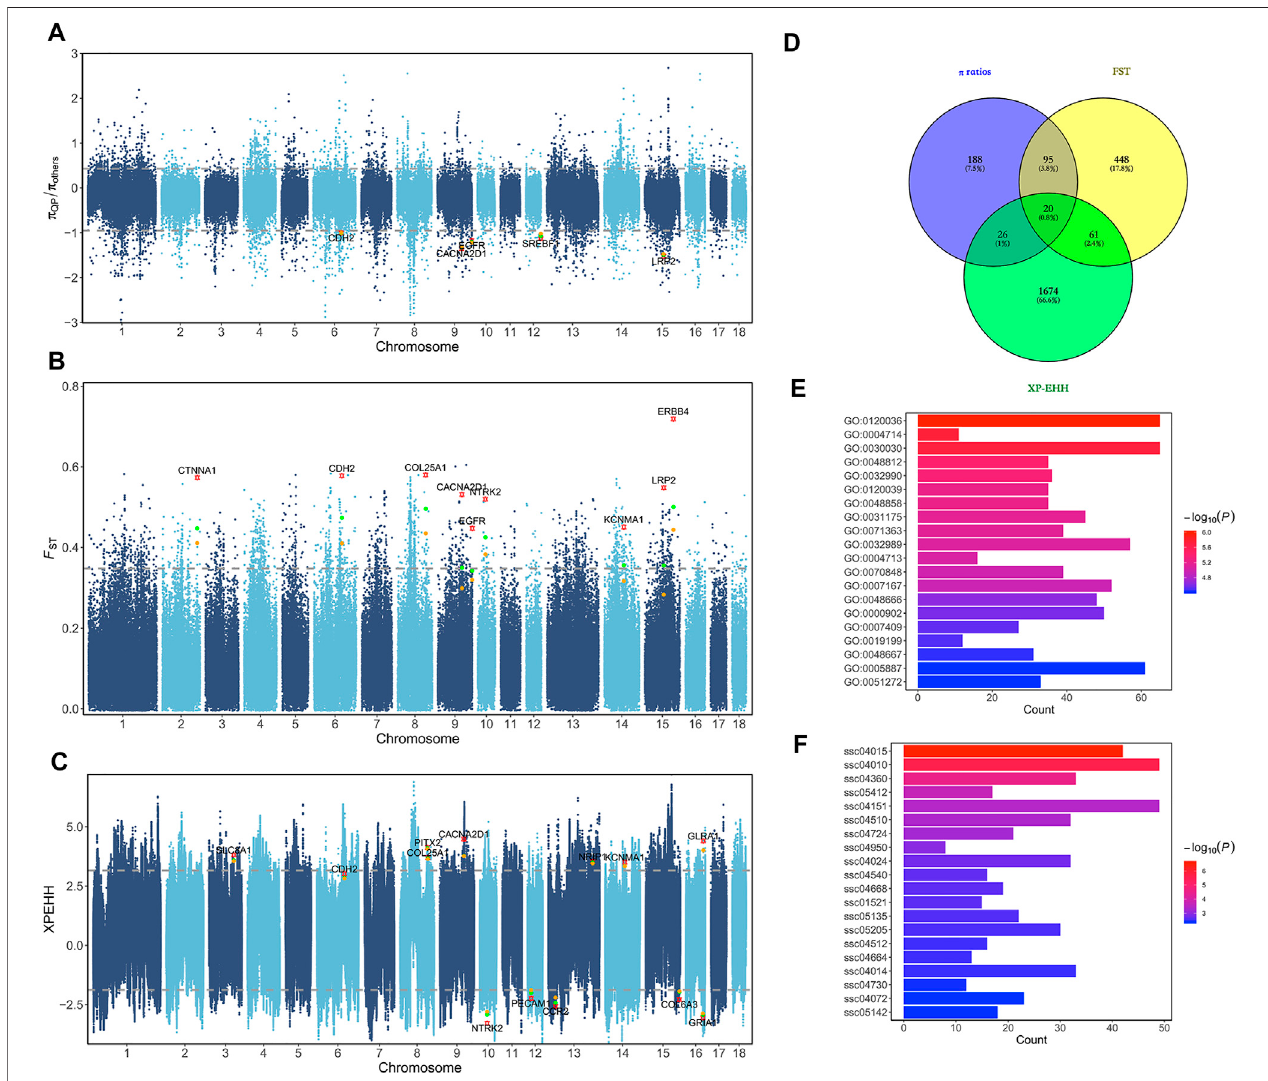
FIGURE2 | Selective sweep analyses for short gestation length. (A) Manhattan plot of π ratios betweenQP and other breeds.The π ratios were transformed using log10. (B) Manhattan plot of F ST between QP and other breeds. (C) Manhattan plot of XP-EHH between QP and other breeds. (D) Venn diagram of selective candidate genes. (E) Bar plot of GO enrichment for selective candidate genes. (F) Bar plot of KEGG pathway enrichment for selective candidate